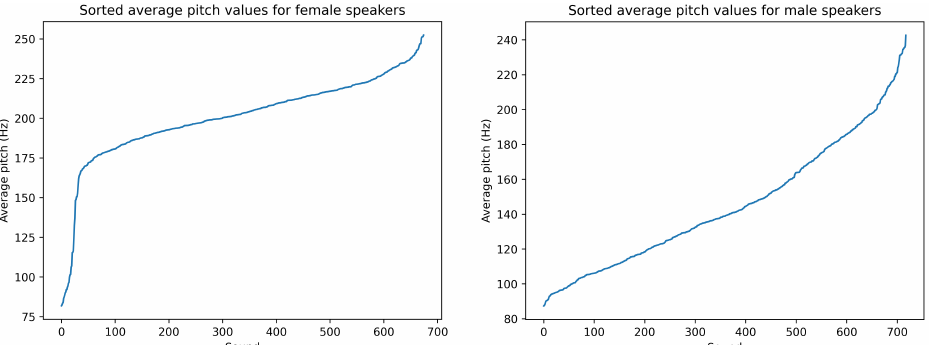
Figure 1. Sorted average pitch values for 1440 utterances by female and male speakers separately. Sounds from each gender category were analysed for average pitch and then sorted for illustra- tive purposes.